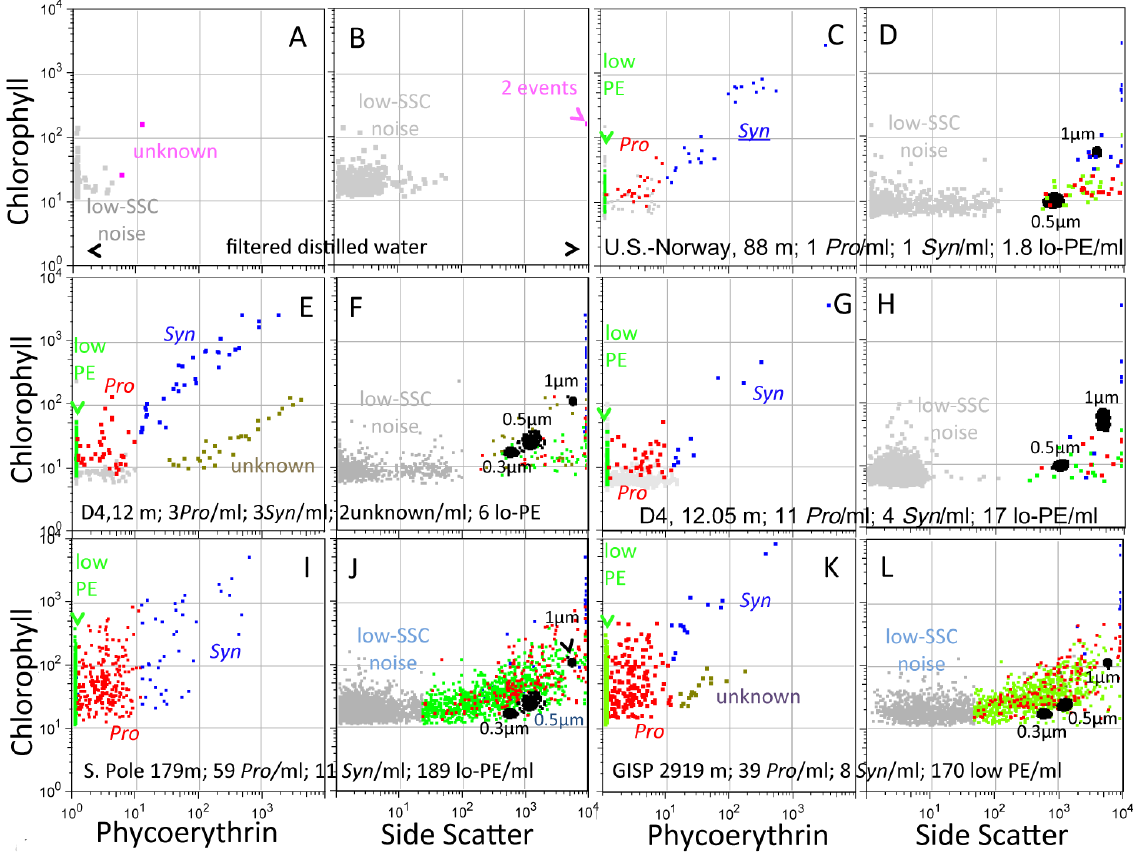
Fig. 6. FCM plots: (A, B) Distilled water was passed through a 0.2µm filter, thresholded on Chl as in the other FCM plots and gated on high SSC; in this and the other plots, gated-out noise is in gray, cells with very low PE are shown in green and the cells were not stained. (C, D) Pro -like and Syn -like cells from an ice core from a depth 88m collected during a traverse from South Pole into East Antarctica (Ansch¨utz et al., 2011). (E, F) Pro -like and Syn -like cells and cells of an unknown taxon from 12.00m depth at site D4, 10km west of the Greenland site at Summit. (G, H) Pro -like and Syn -like cells at 12.05m at site D4. (I, J) Pro -like and Syn -like cells from 179m at South Pole. (K, L) Pro -like and Syn -like cells, and cells of an unknown taxon from 2919m depth at GISP2 (Summit). Beads in D, F, H, J and L were added after the runs, with all FCM settings unchanged. The gain on the Chl phototube was set higher for plots I to L than for A to H . Cell concentrations were calculated after dividing by volume of liquid run and concentration resulting from